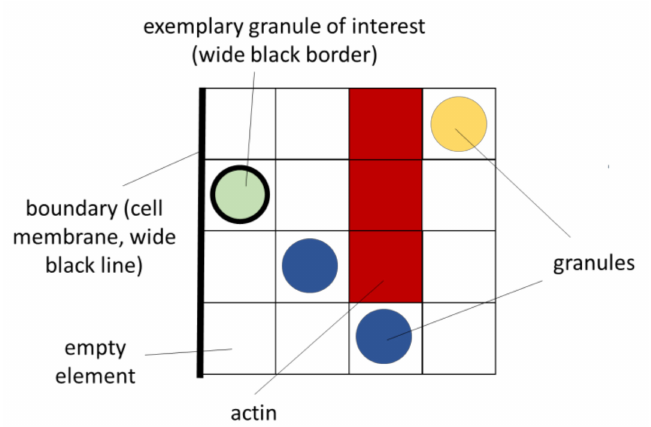
Figure 9. Exemplary 2D configuration for the following rules and identification of the included features.